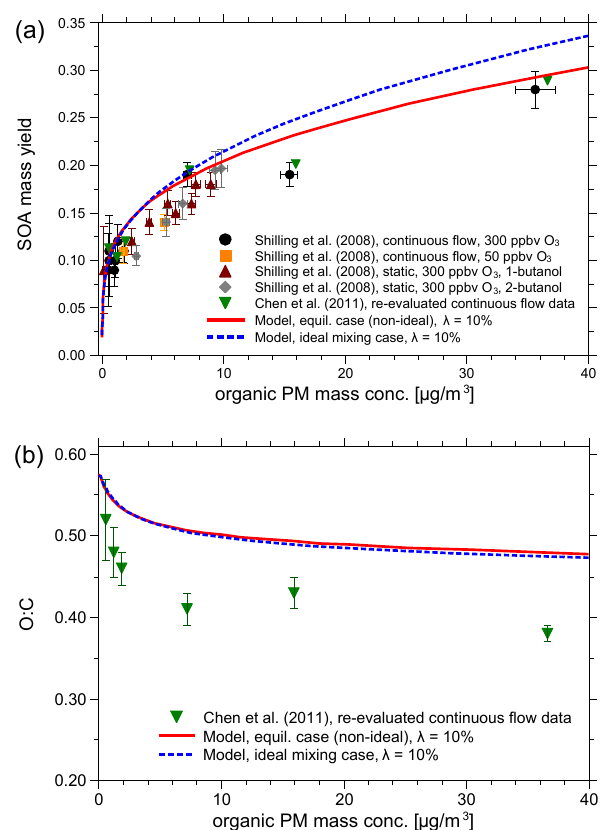
Fig. 3. Comparison of aerosol chamber data and model calculations for atmospherically relevant loading levels of α -pinene SOA. Ex- perimental conditions: 298K, 40% RH, dry ammonium sulfate seed particles, chamber operated in continuous flow or in static “batch” mode, as described in Shilling et al. (2008). Model calculations per- formed at the same temperature and RH for the ammonium sulfate- free system using parameter λ = 10% for the degree of dimer for- mation. AIOMFAC predicts the one-phase system to be stable. (a) Measured and calculated mass yield vs. SOA mass loading. (b) Loading-dependent mean O:C atomic ratio of the organic PM mix- ture. Green triangles: continuous flow data at 300ppbv ozone of Shilling et al. (2008, 2009) as re-evaluated by Chen et al. (2011). Note: experimental data are not corrected for chamber